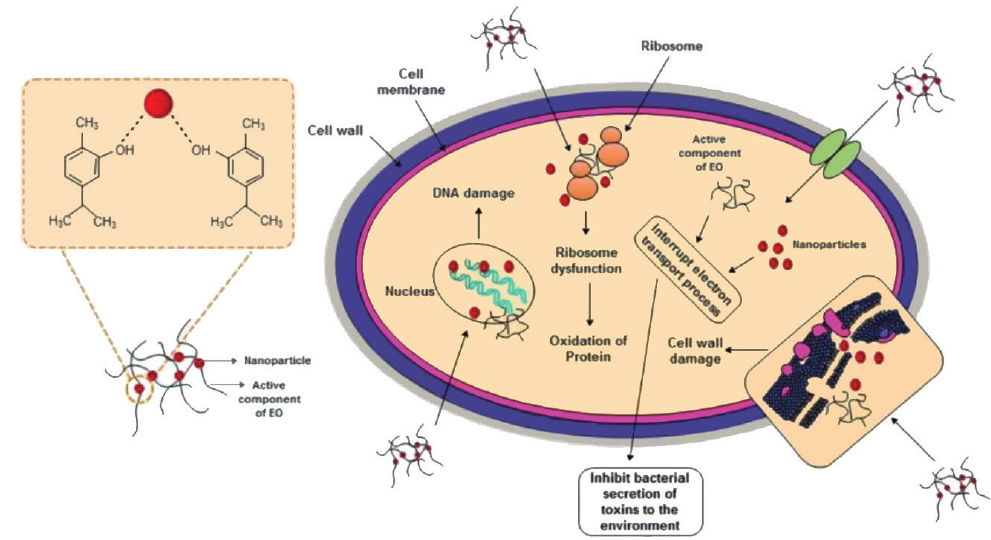
Figure 9 Antimicrobial effect of nanoparticles used with functional essential oils